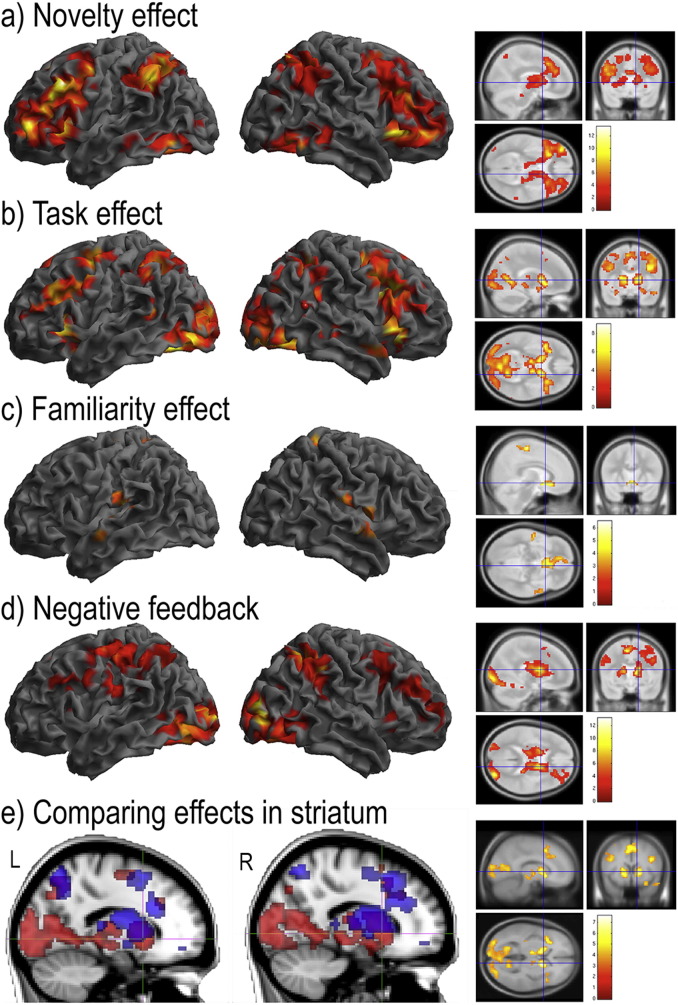
Supplemental whole-brain analyses of data from Study 2 (all rendered at p < 0.05 FWE cluster corrected for the whole brain volume). Voxelwise analysis using a Novelty contrast during learning from feedback (Stages 1–5 weighted as 2 1 0 − 1 − 2) rendered significant activation across the frontoparietal cortices and within the striatum (S3a). A similar pattern of activation was evident for the Task contrast (Stages 1–5 all weighted as 1) (S3b). A set of regions within the medial orbitofrontal cortices and temporal lobes were more active when rules were familiar (S3c). Negative feedback generated strong activation within the frontoparietal cortices and within the striatum (S3d). Notably, peak coordinates within the caudate varied between the contrasts (S3e), with mid/ventral regions including the nucleus accumbens, putamen and ventral caudate activated by negative feedback (rendered in red on the sagittal images) but not Novelty (rendered in blue on the sagittal images). Comparing directly between these contrasts (inset on the right) showed that the feedback-familiarity difference was significant at the whole brain corrected threshold, whereas the reverse contrast was not significant even at the uncorrected threshold of p < 0.05. The peak striatum coordinates for this contrast of contrasts (left x = − 12 y = 5 z = 4; right x = 15 y = 8 z = 4) were within 5 mm of the centres of the caudate ROIs (left x = − 12 y = 10 z = 4; right x = 12 y = 12 z = 4).